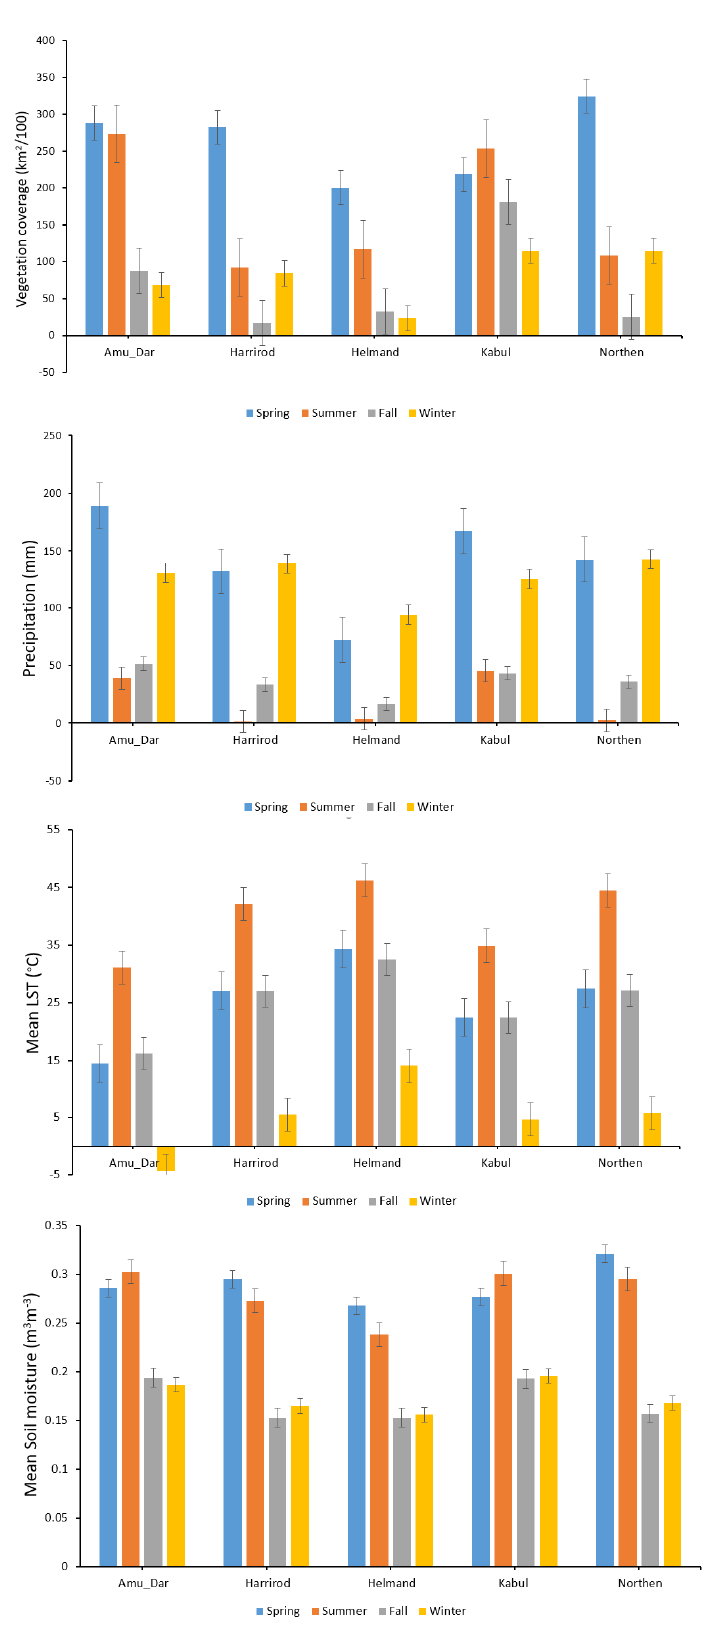
Figure 8. The seasonal averages of LST, precipitation, soil moisture, and vegetation coverage in Afghanistan’s basins in the period